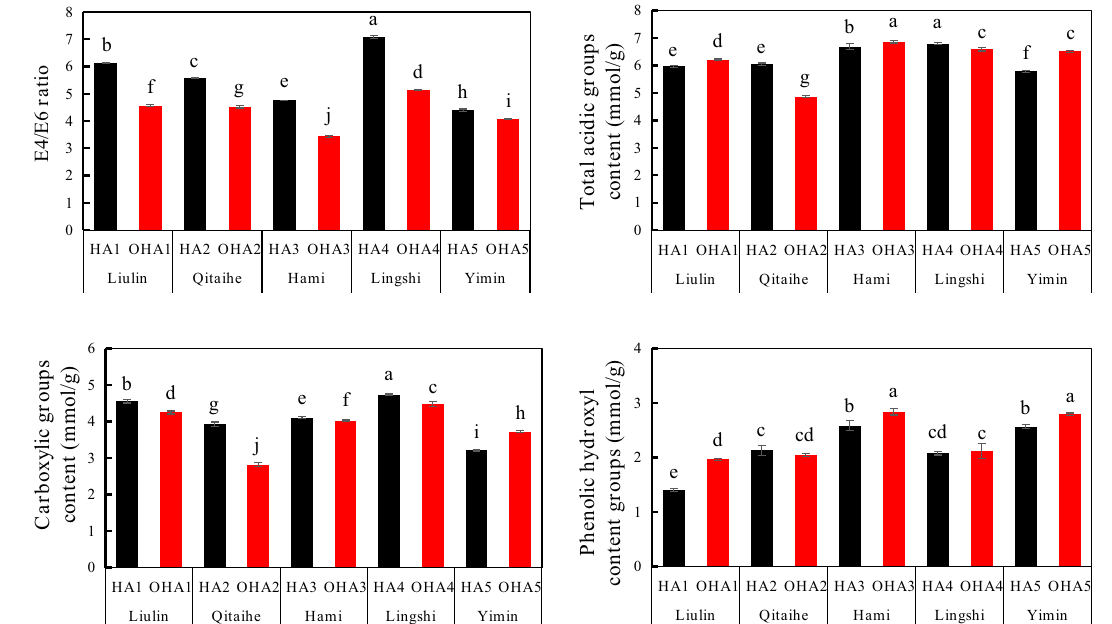
Figure 2. E4/E6 ratios and acidic functional group contents of HAs. HA1–HA5, the HAs extracted from original coal (black); OHA1–OHA5, the HAs extracted from oxidized coal (red); Liulin, Qitaihe, Hami, Lingshi and Yimin, the origin of